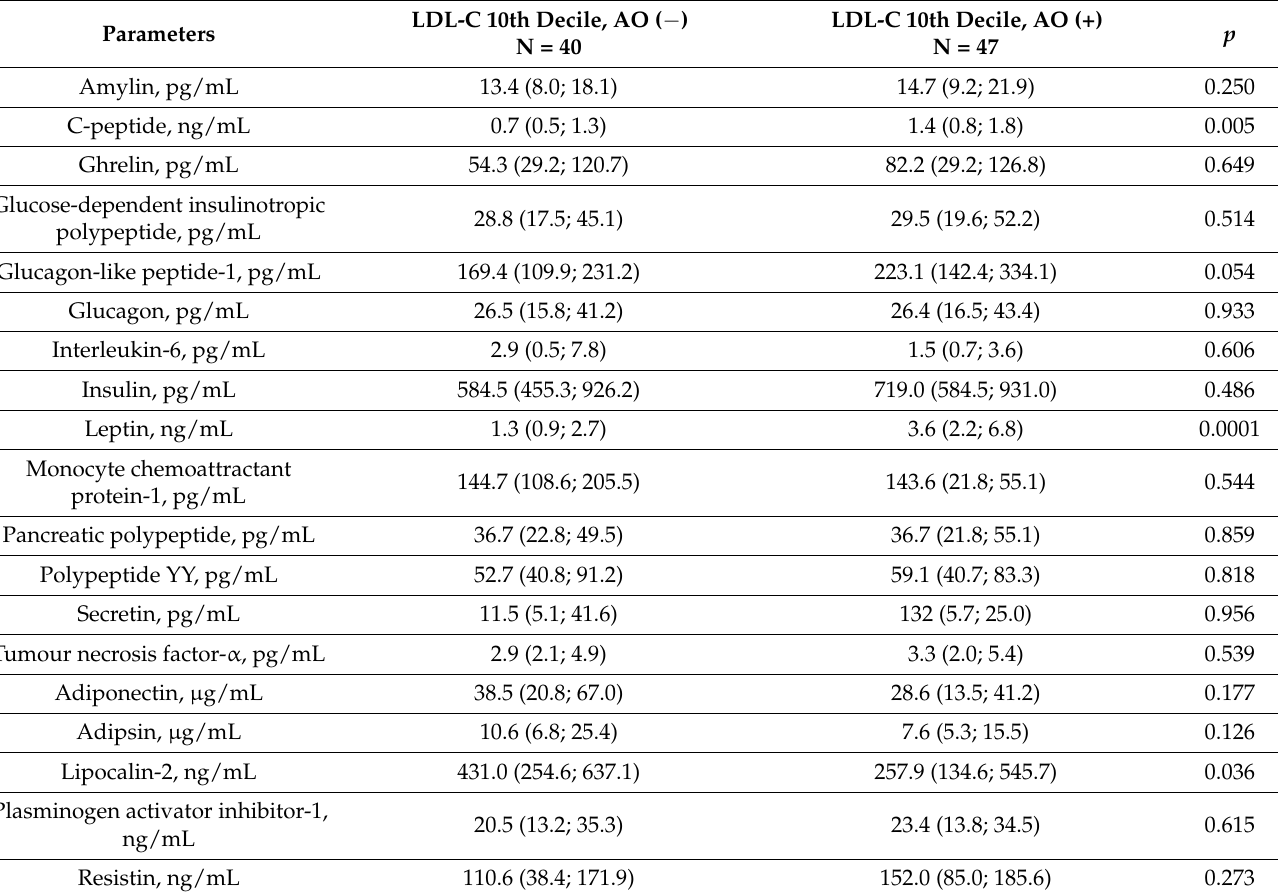
Table 2. Analysis of blood levels of adipokines/cytokines associated with the secretory activity of visceral adipocytes in men with hyper-LDL-C with and without AO (Me (25%; 75%)).